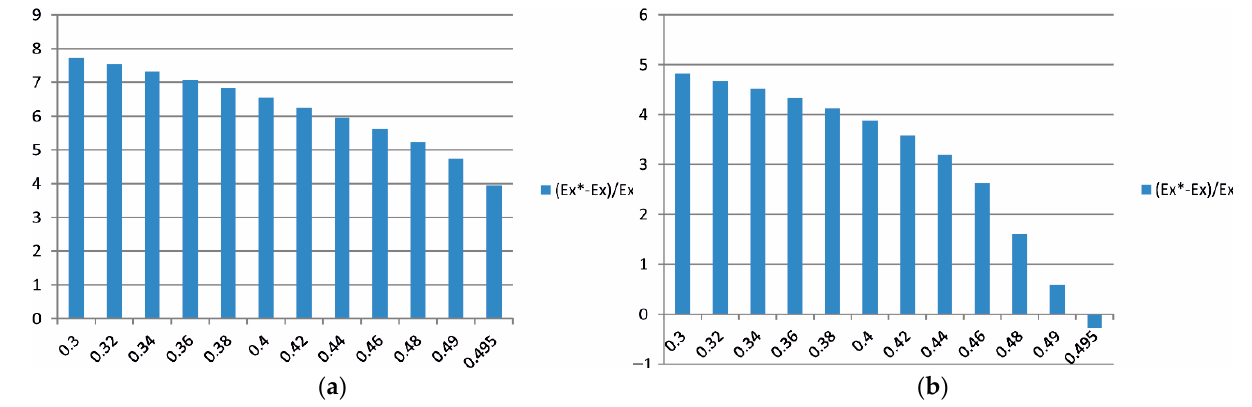
E modulus of asphalt con- x E and ( b ) E /the (i) optimisation r 0 − E ) / E x x can be treated as x